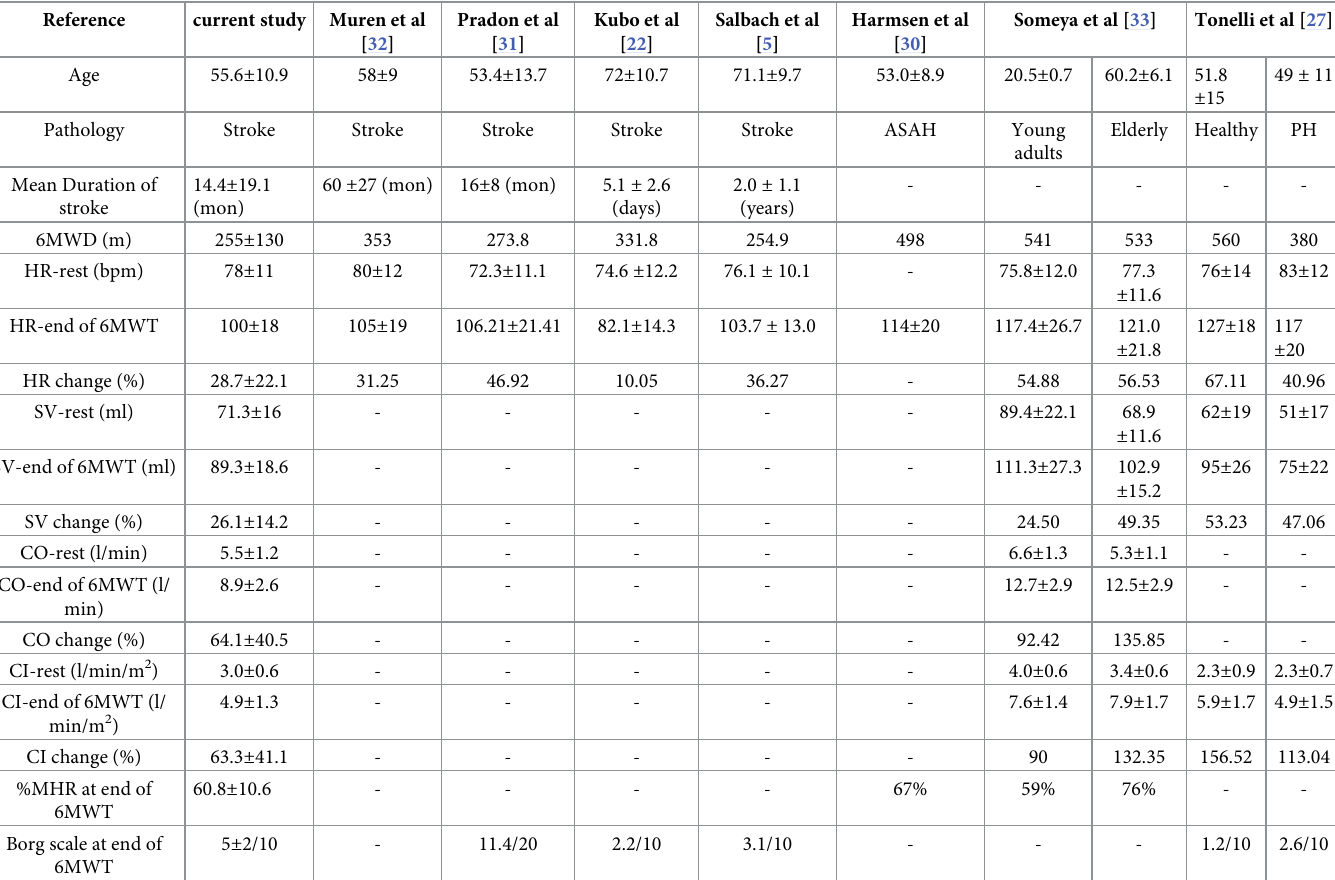
Table 2. Heart rate and cardiodynamic parameters during a 6MWT reported in previous literature in comparison to data recorded in the current study. Reference